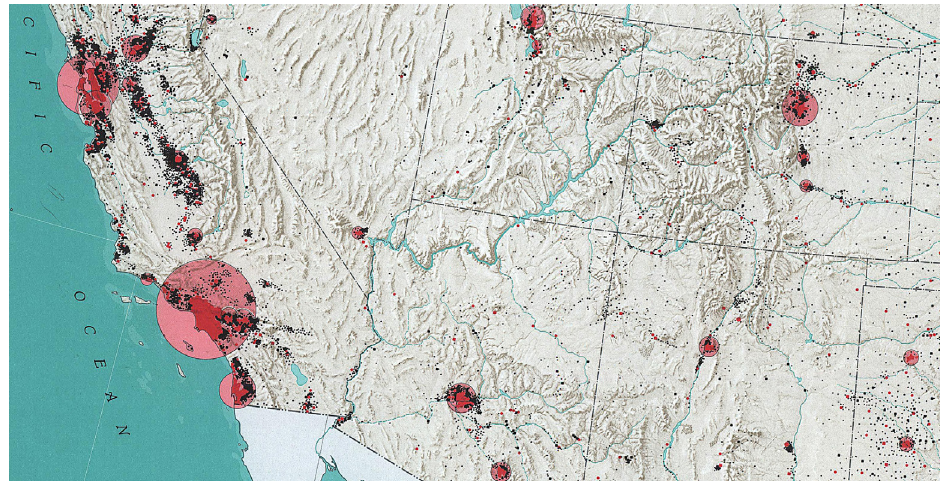
Fig. 2. A part of the dot map, or more precisely a diagram-dot map, of the population distribution in the United States. Its base contains shaded land relief, built-over areas of cities (population numbers shown in diagrams) and a relatively detailed water network; original scale 1:7,500,000, reduced by half (source: The National Atlas of the United States of America , 1970, https://www.lib.utexas.edu/maps/ national_atlas_1970.html, access